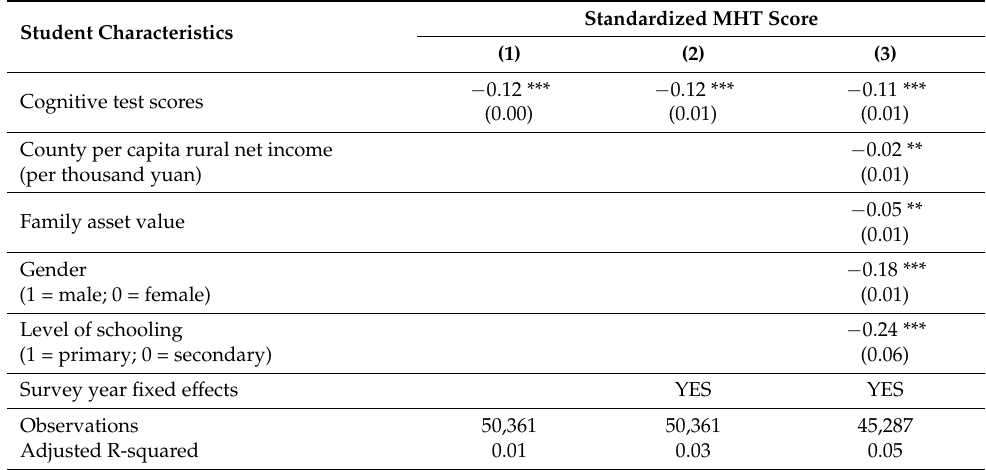
Table 4. Correlation between student standardized MHT scores and selected student